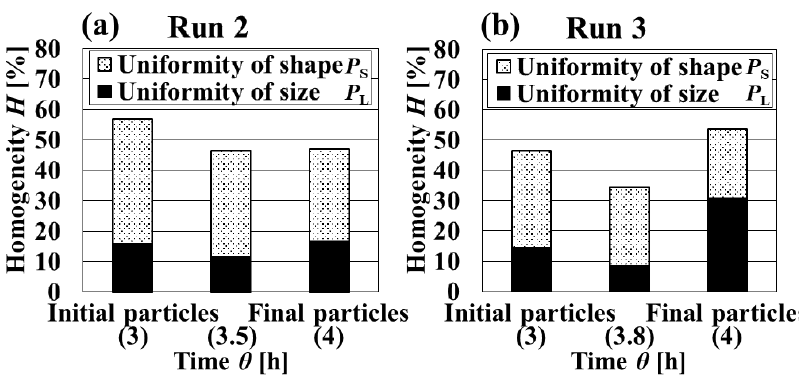
Figure 5. Dynamic variation in the homogeneity and uniformity of the distributions of particle size and crystal shape with the crystallization time. ( a ) Run2. ( b ) Run3.